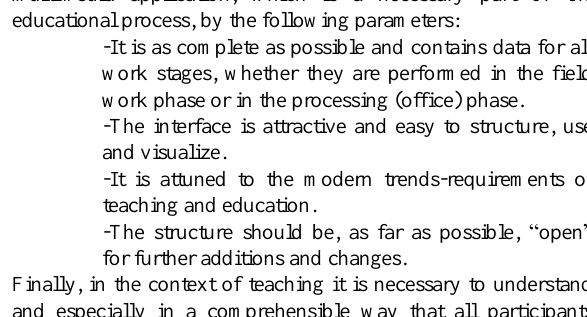
Figure 7 . Subsections and records of work stages of restoration study through documentation stage.